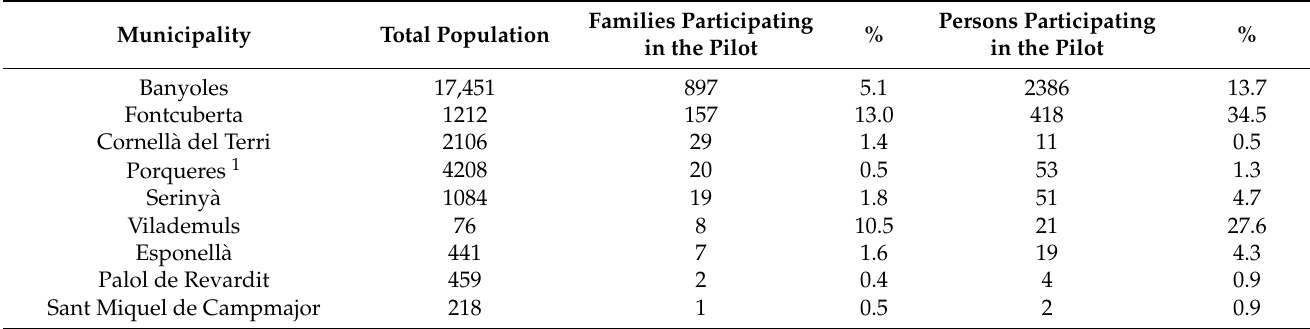
Table 2. Number of participating families per municipality in the pilot